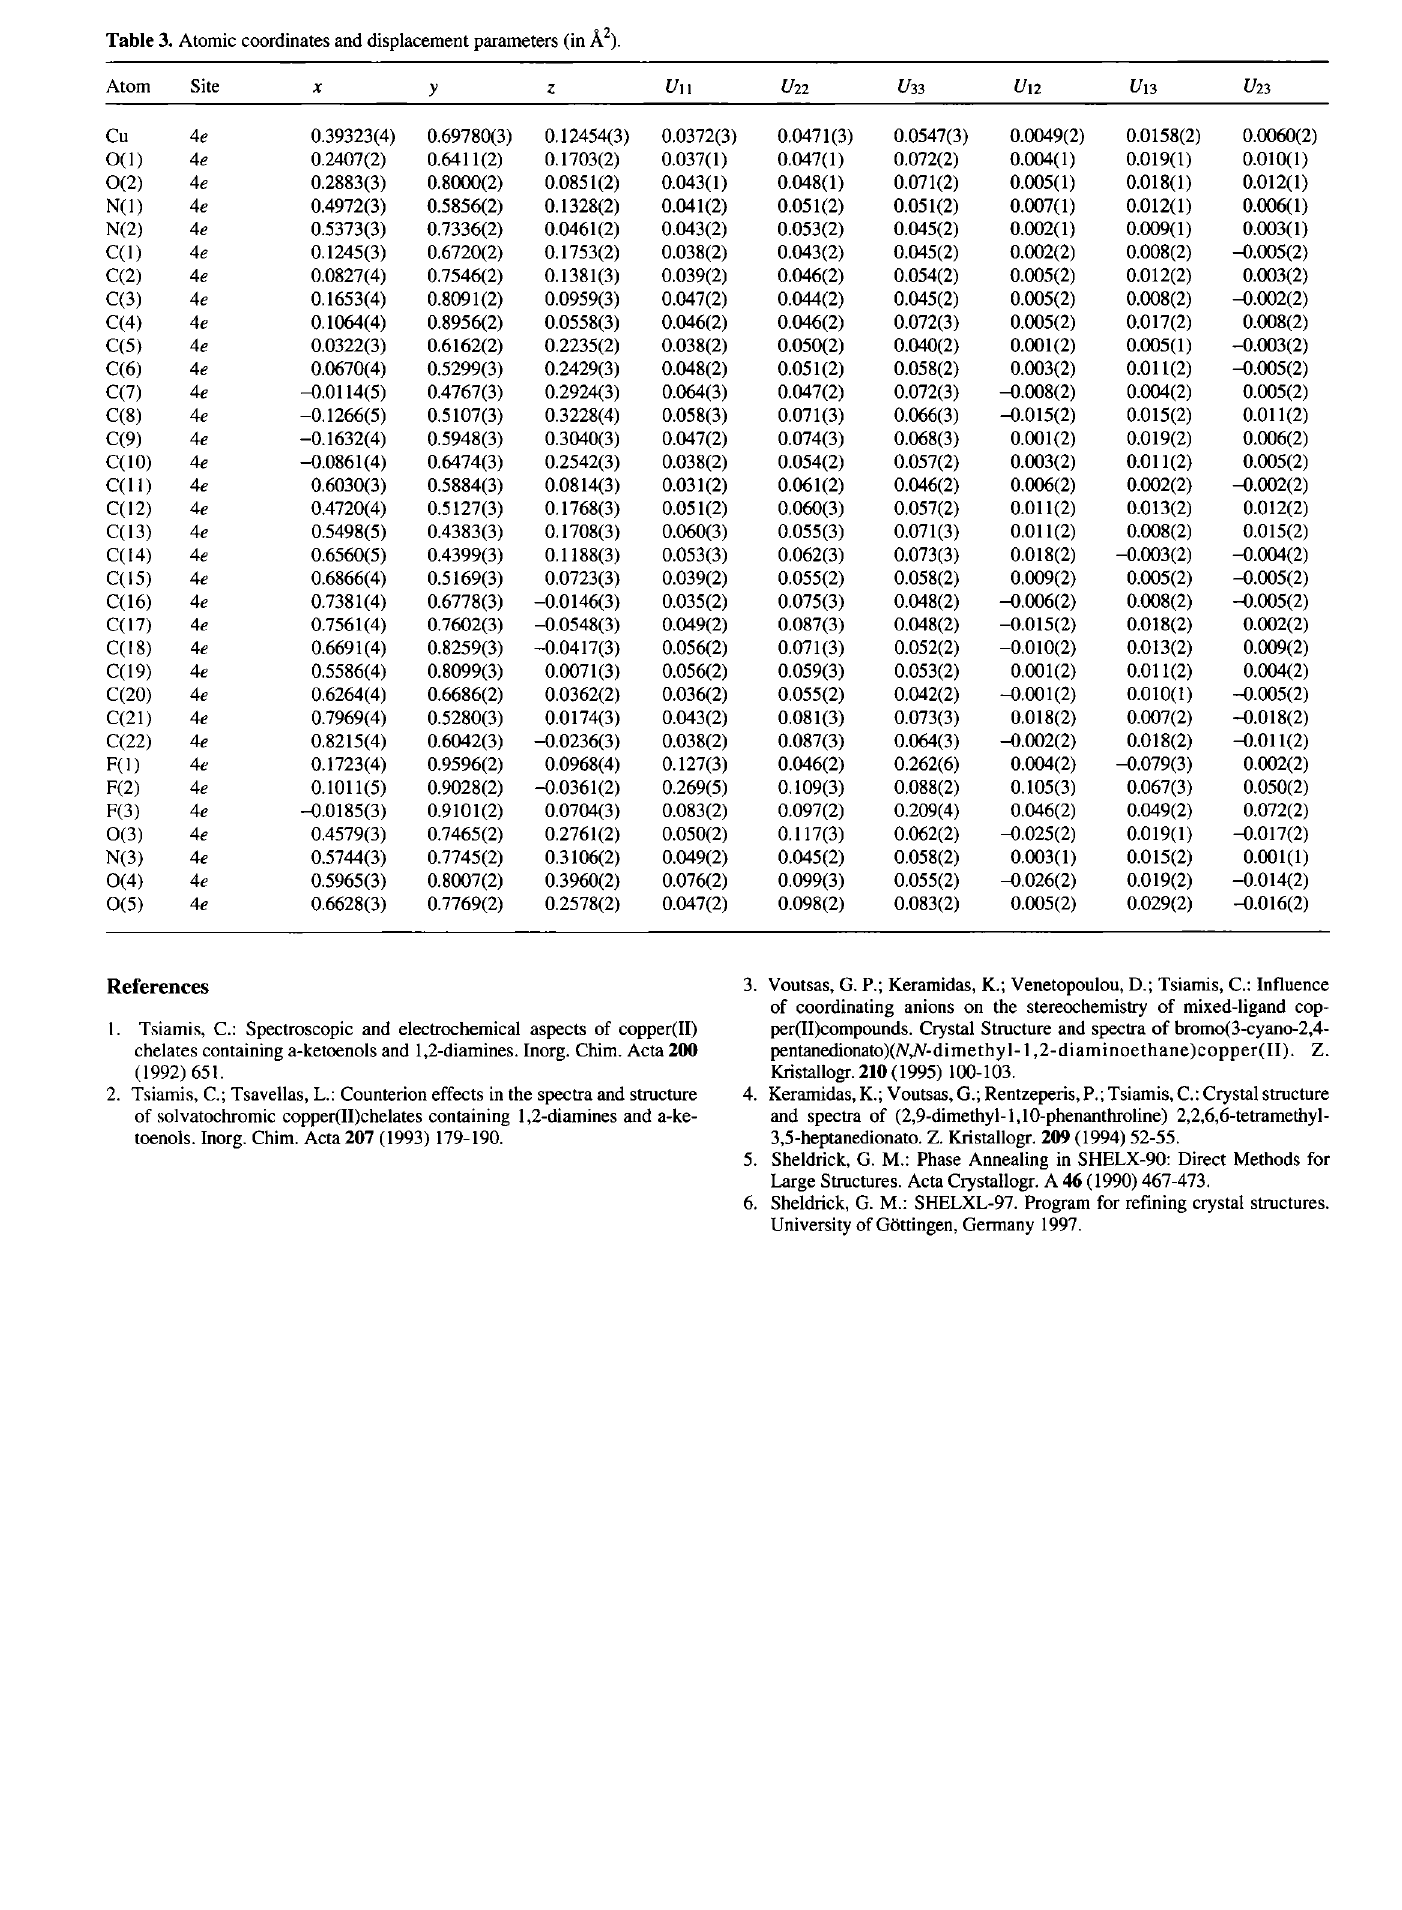
Table 3. Atomic coordinates and displacement parameters (in Â 2